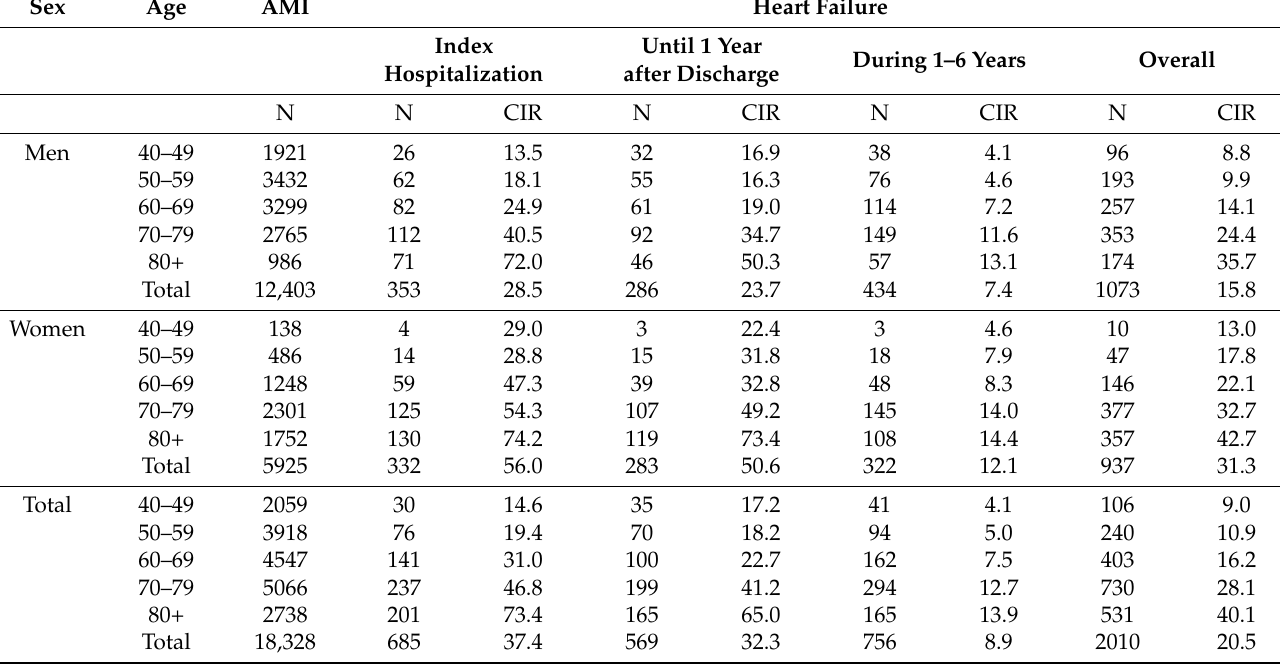
Table 2. Cumulative incidence of HF among newly developed AMI during 6 years follow-up according to sex and age.